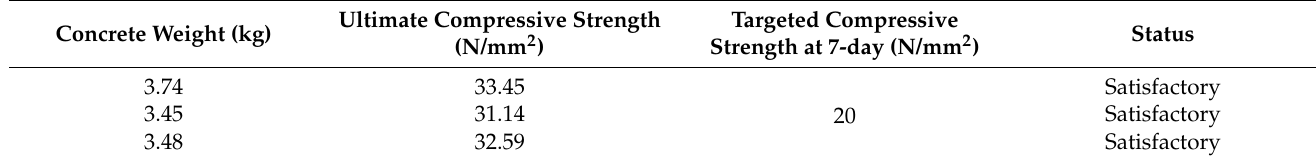
Table 4. Compressive strength of 7-day-cured cylindrical